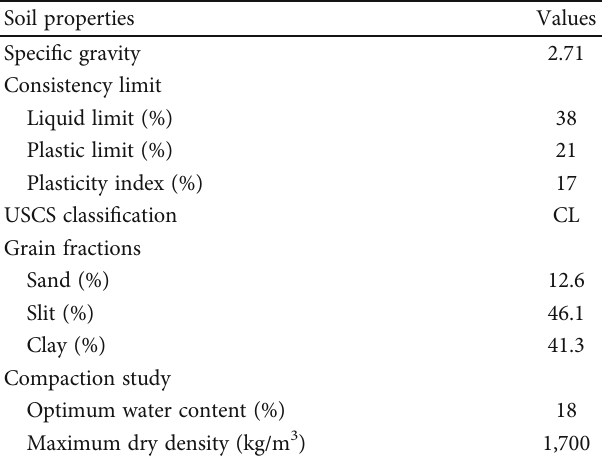
Figure 1: Particle size distribution curve of the soil used. Table 1: Physical properties of soil.